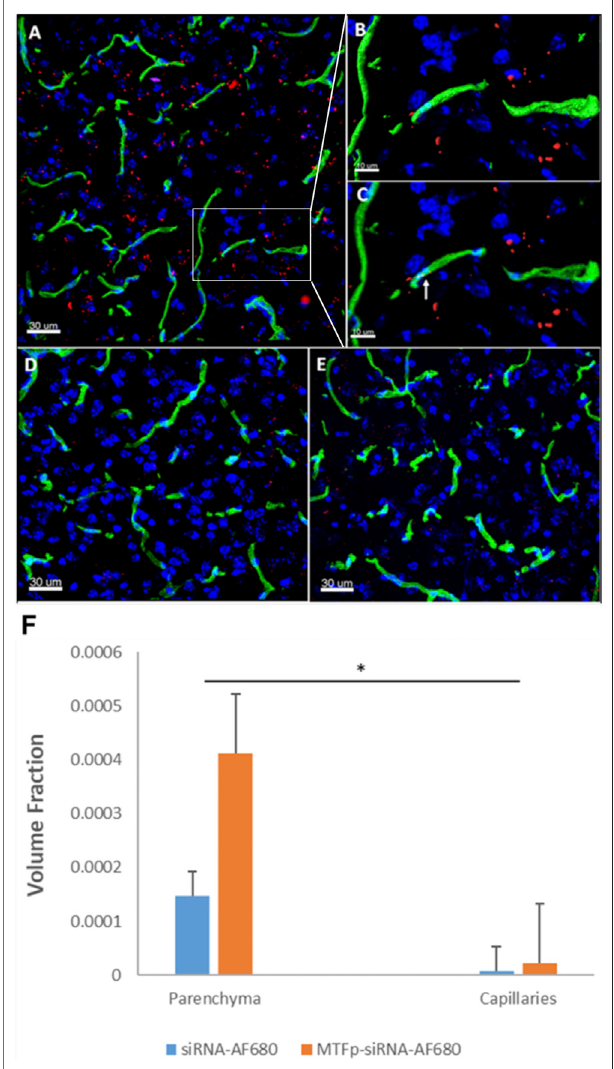
FIGURE 2 | Conjugation to MTfp enables siRNA to cross an intact BBB and into the brain parenchyma. Representative 3D confocal images showing localization of MTfp-siRNA in the brain of mice with intact BBB. Cell nuclei are blue (DAPI) and capillaries are green (Tomato lectin-FITC). (A) AF680 fl uorescence (red) in the cerebral cortex sections from a mouse treated with MTfp-siRNA AF680 ; (B) Shows the enlarged area that has been surface- rendered to indicate the surface of the capillaries where FITC labelled capillaries (green) and MTfp-siRNA AF680 (red); (C) Shows the enlarged area where MTfp-siRNA AF680 is localized within the blood capillaries (yellow dots, see arrow); ( D) AF680 fl uorescence (red) in the mouse cerebral cortex treated with PBS (i.e., background fl uorescence); (E) Control AF680 fl uorescence (red) in the mouse cortex treated with siRNA AF680 . (F) Distribution of MTfp- siRNA in the cortex of wild type mice with intact BBB. Values indicate total AF680 fl uorescence normalized to total tissue volume (VTA in Supplementary Table S1 ) and then normalized to the total AF680 fl uorescenceseeninPBS(background).Dataarerepresented asmeans ± SD ( n (cid:2) 3, eight fi elds of view per animal). * p -value <